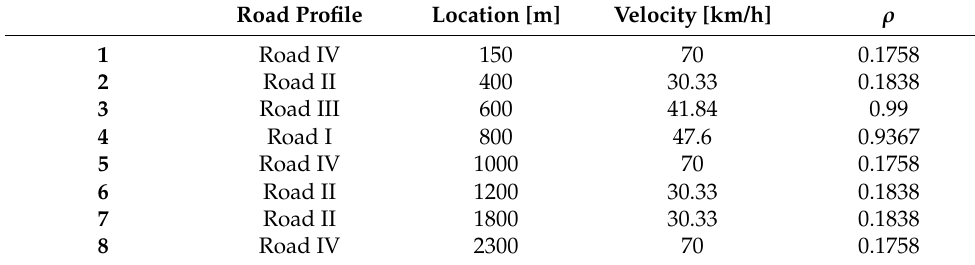
Table 4. Road profile